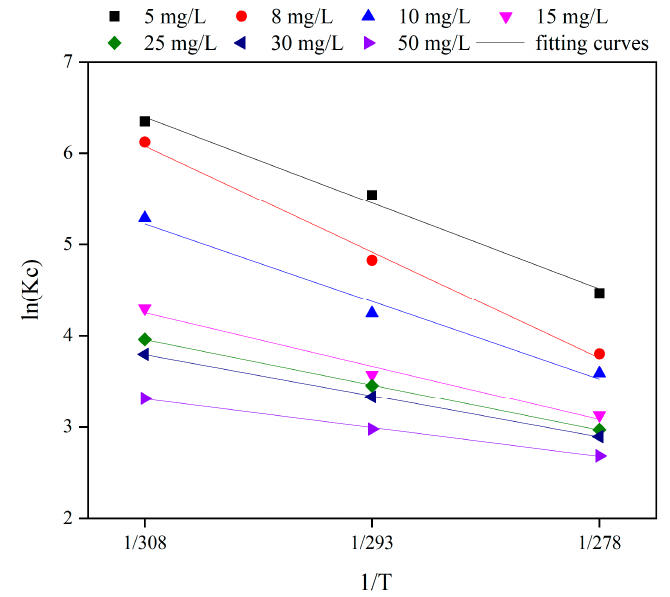
Figure 13. The relationship between ∆ G θ and T for the adsorbed ammonium on bio-ceramsite under different reaction concentrations. Table 8. Thermodynamic parameters for the adsorption of ammonium on